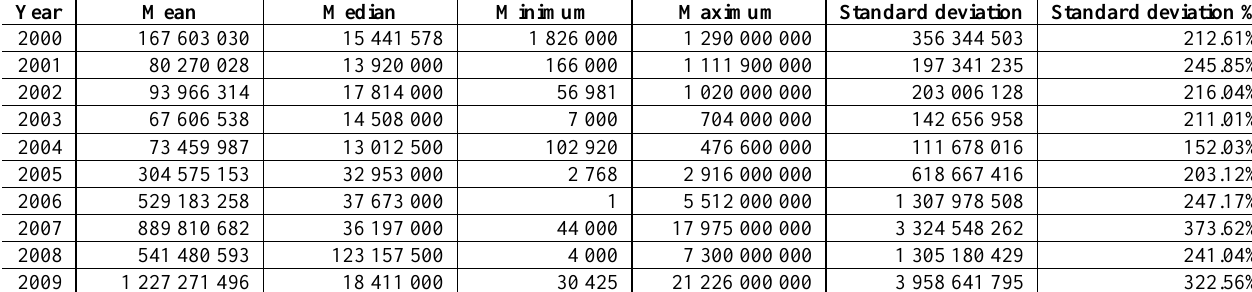
Table 1: Descriptive statistics on annual share